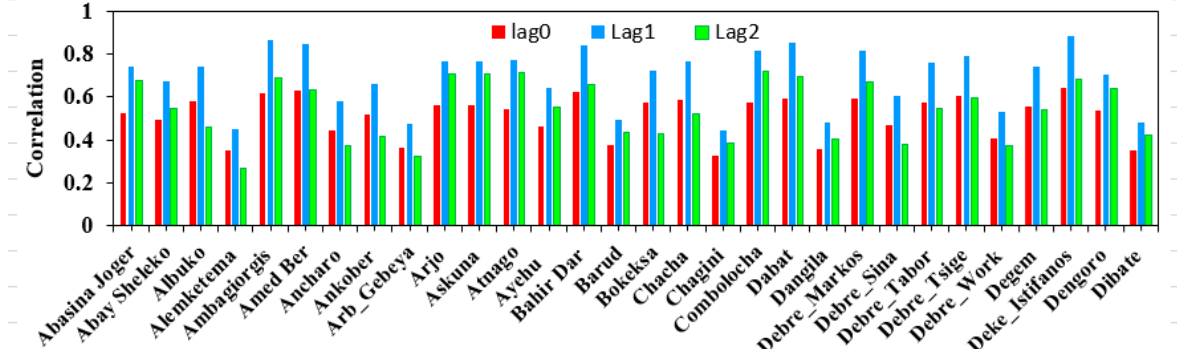
Figure 7. Correlation between observed rain gauge and river flow at El Diem station at lag 0, lag 1, and lag 2 at a monthly scale (1966–2008).